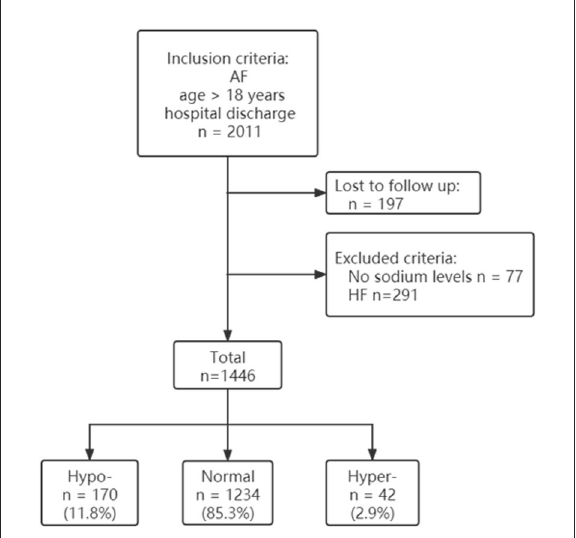
FIGURE1 Participant flow diagram. AF, atrial fibrillation; HF, heart failure; Hypo, hyponatremia; Normal, normonatremia; Hyper,